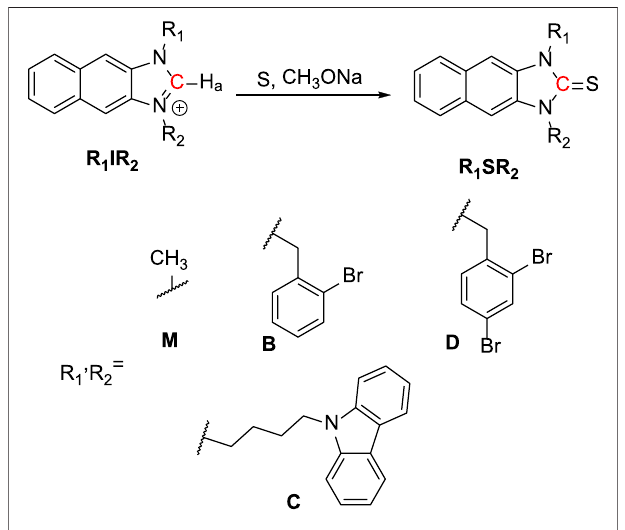
Frontiers in Chemistry |